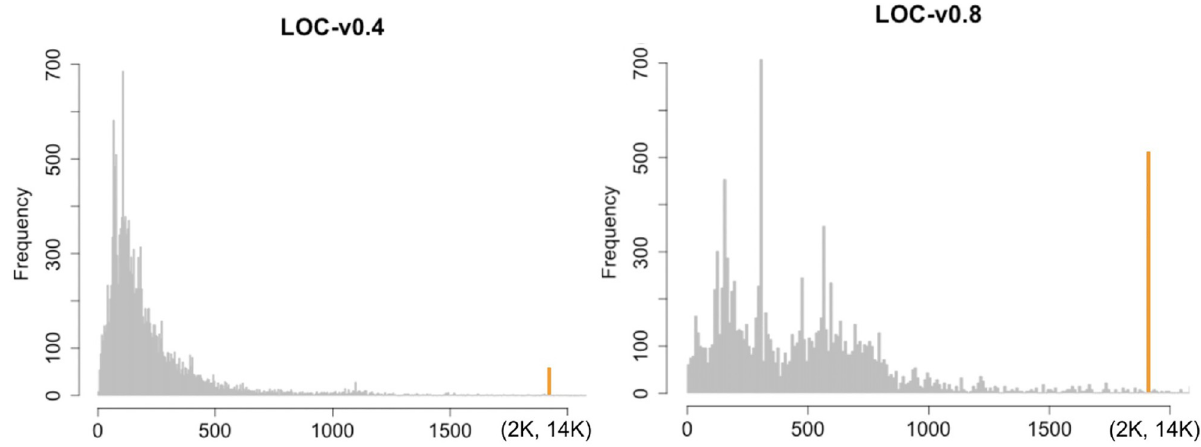
Fig 8. Smart Contracts’ LOC distribution vs. pragma